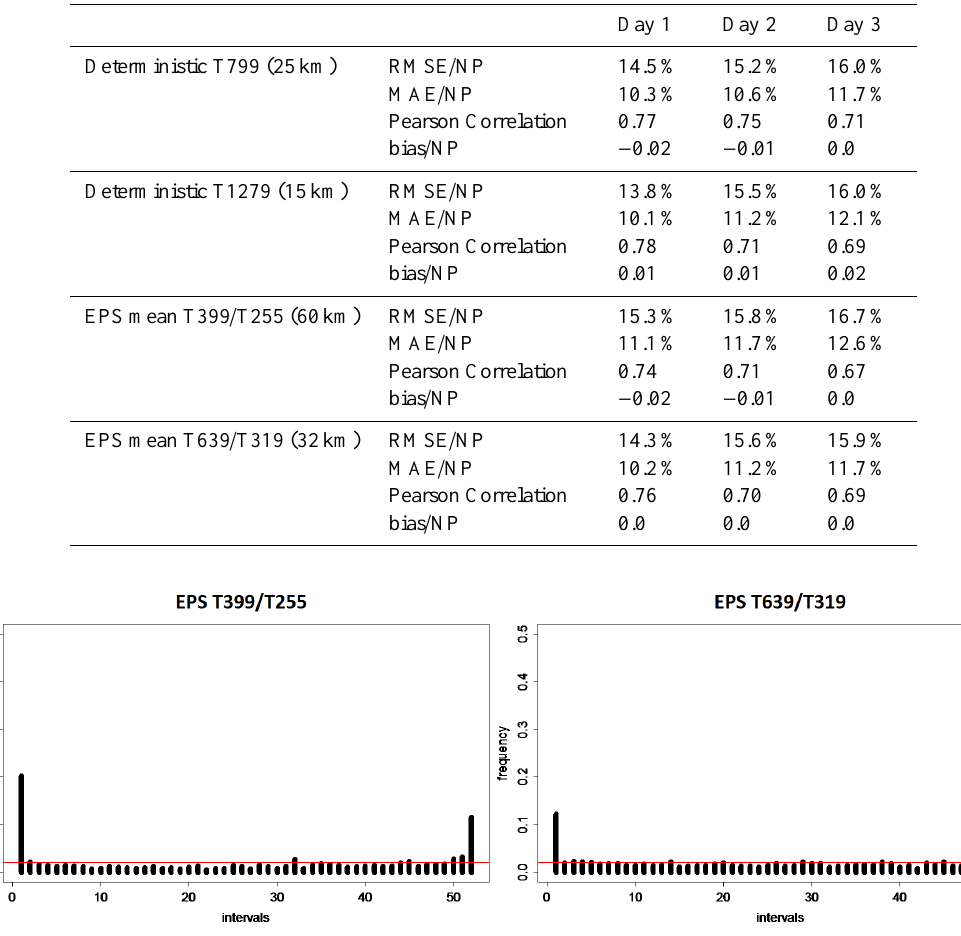
time 0h to + 24h (Day 1), + 24h to + 48h (Day 2) and + 48h to + 72h (Day 3) where 0h refers to 00:00UTC, the beginning of each 3 days